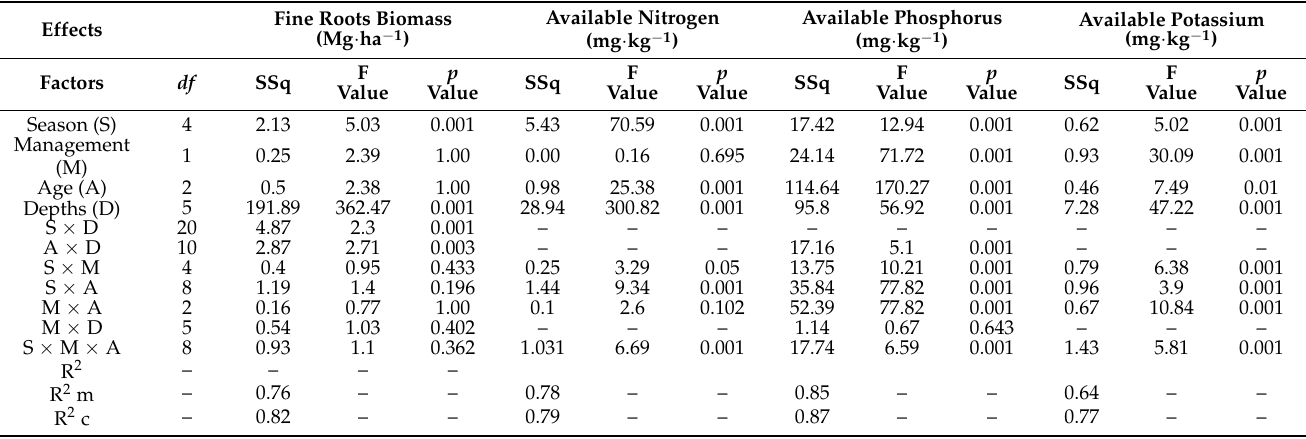
Table 1. Linear mixed-effect model values attained testing effects of different management systems (M), stand age (A), seasons (S), and soil depths (D) on fine root biomass and available nutrients.